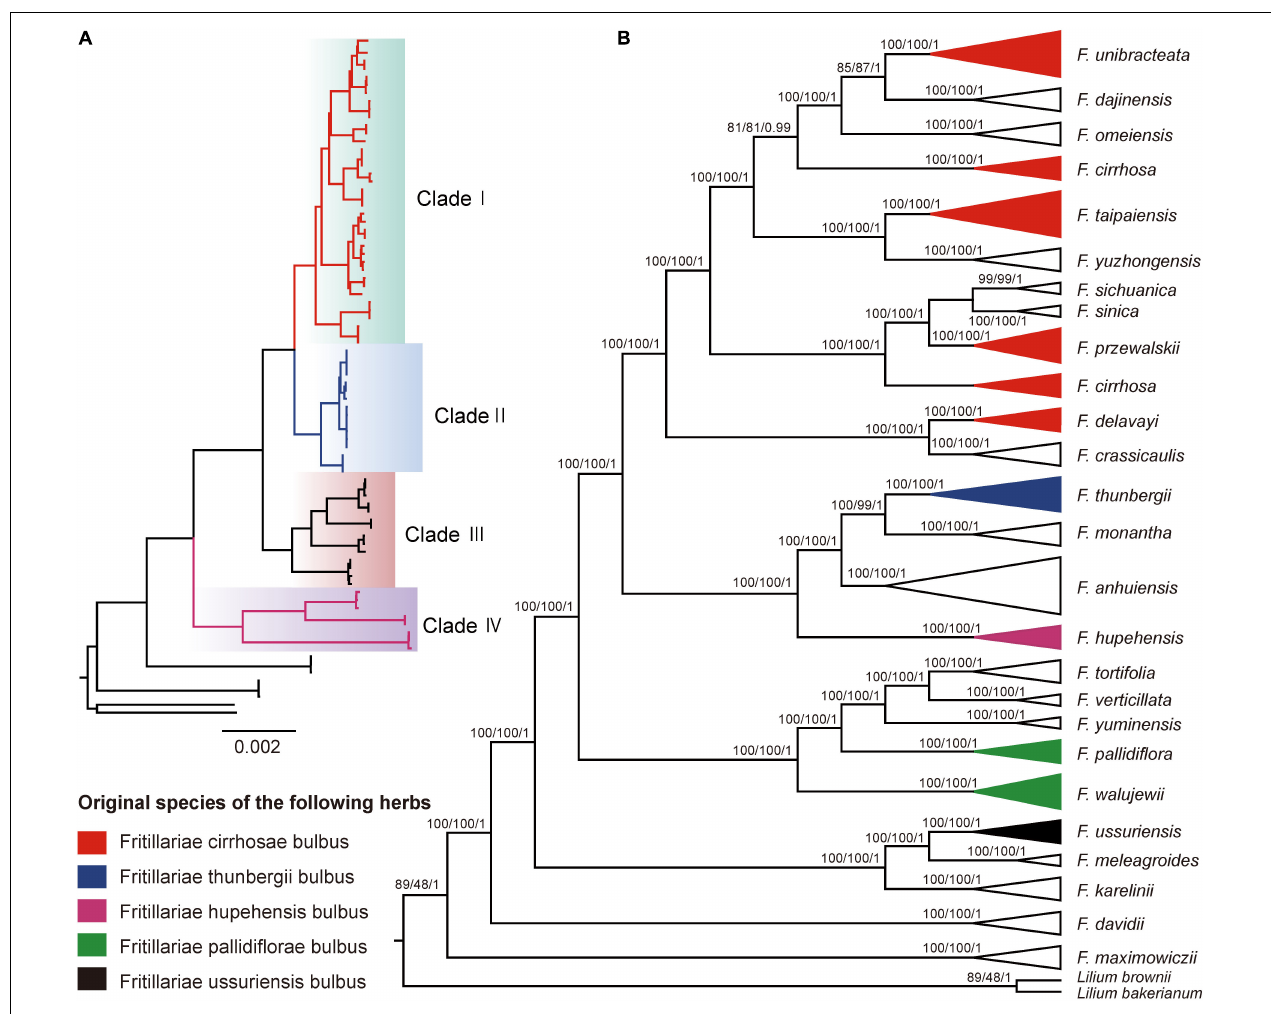
FIGURE 4 | Phylogenetic analysis of 25 Fritillaria species inferred from maximum likelihood (ML), maximum parsimony (MP), and Bayesian analyses (BI) based on the complete chloroplast genomes. ML topological structure is shown on the left of the figure (A) . For the topological structure on the right of the figure (B) , the numbers above nodes are support values with ML bootstrap values on the left, MP bootstrap values in the middle, and Bayesian posterior probability (PP) values on the right. Colors represent the four major clades of the genus Fritillaria in China (A) and the original species of five Fritillariae bulbus of traditional Chinese medicine (B) .